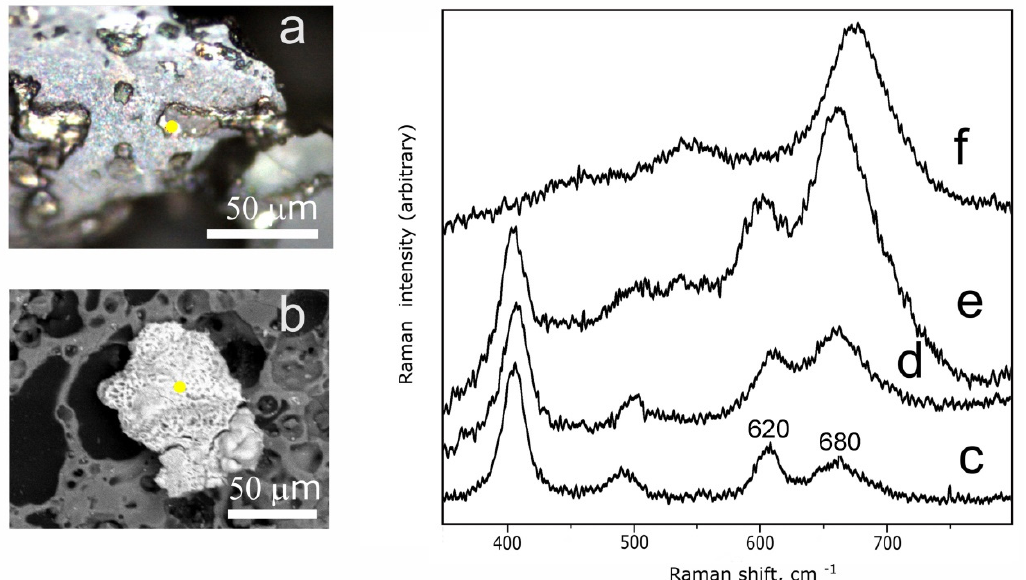
Figure 7. BSE image of hematite ( a ) and magnetite ( b ); Raman spectra of hematite from local Karelian pottery fired at temperatures below 900 °C; ( c ) and above 1000 °C; ( d ) [21] and hematite shown in ( a ); ( e ) and magnetite shown in ( b ); ( f ) from the crucible fabric. The yellow dots mark the point Raman analysis.